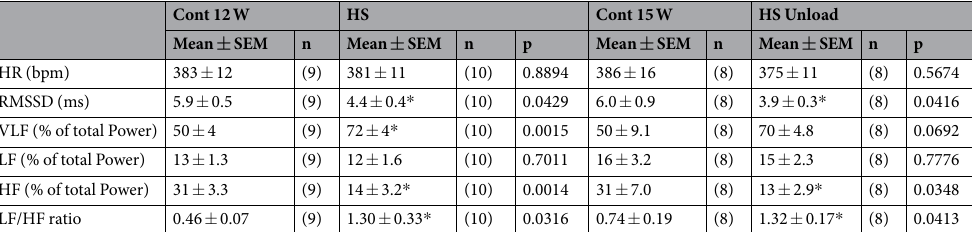
Table 1. Frequency and time domain variability results of the systolic interval (SI) from HS, HS-Unload and respective control groups. SI data were acquired from 4,000 to 4,500 consecutive heart beats using the pulsatile blood pressure signal (approximately 10 minutes of continuous recording). Very low frequency (VLF), low frequency (LF) and high frequency (HF) bands ranged from 0.0 to 0.2 Hz, 0.2 to 0.75 Hz and 0.75 to 2.50 Hz respectively. RMSSD = root mean square of the successive differences was used to assess time-domain heart rate (HR) variability. Total Power density was measured as µ s 2 . * Different of respective control group; unpaired t -test; p < 0.05.